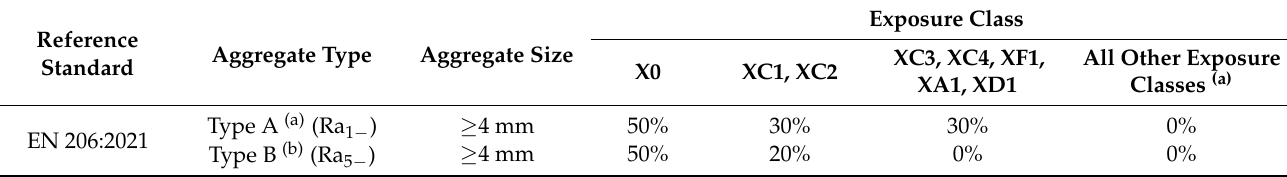
Table 5. Percentage of substitution of natural aggregate by bituminous aggregates (Ra 1, Ra 5 ) according to EN 206 as a function of the exposure class.